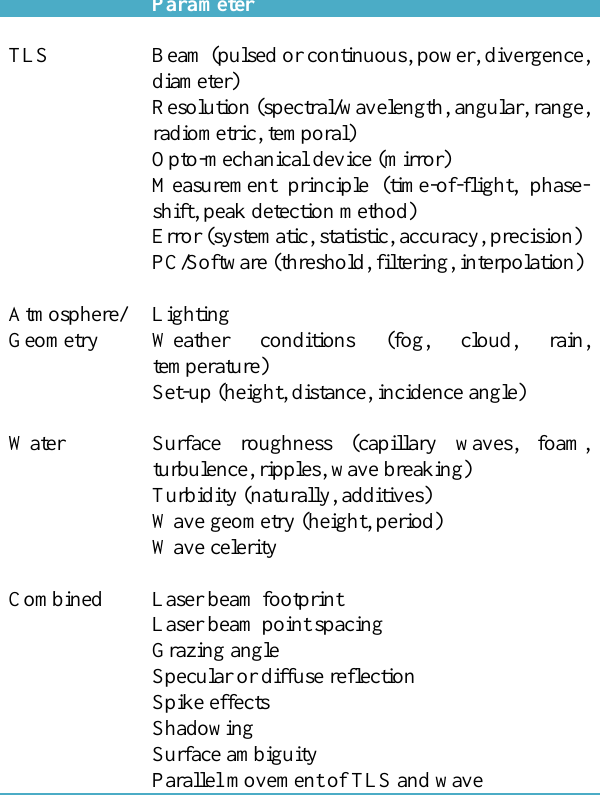
Table 1: Influencing parameters on scanning water waves A distinction is made between airborne, outdoor terrestrial and laboratory laser range measurements of water surfaces.